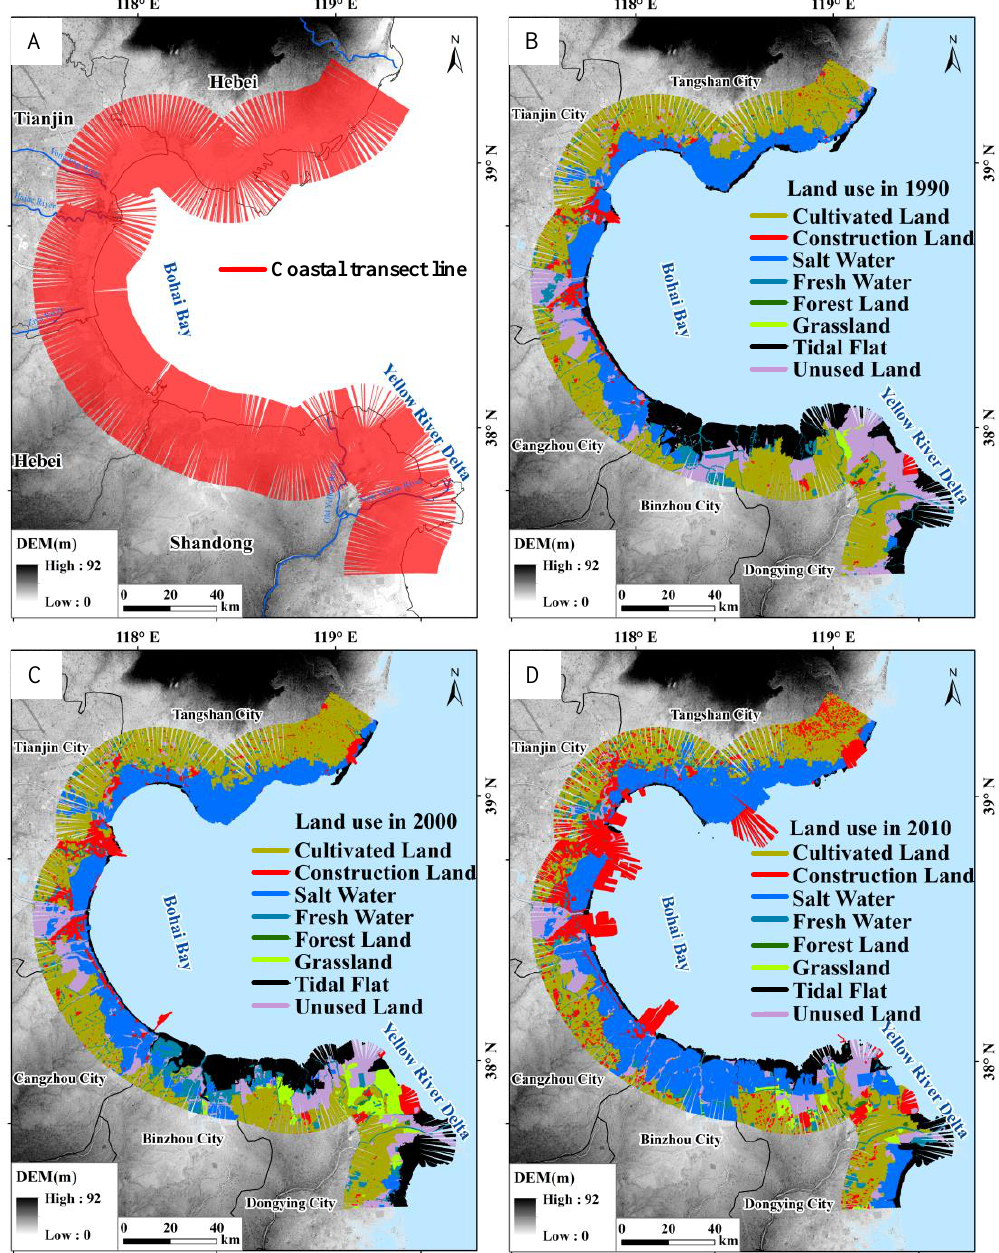
Figure 5. Coastal transect lines ( A ) and land use data from 1990 to 2010 ( B – D ).